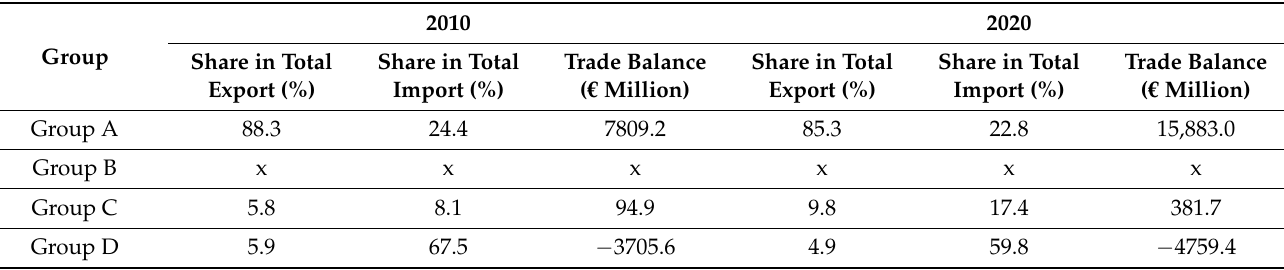
Figure 2. Mapping of selected groups of agri-food products exported from the EU to the USA depending on the level of comparative advantages and the degree of export specialization in the years 2010 and 2020 (the Widodo approach). Note: the figures present only the groups of products, which share in the structure of export or import to/from the USA in at least one analyzed year amount to min. 5%. Source: The author’s elaboration based on data from Table 5. Table 6. Shares of individual groups of products resulting from mapping by the Widodo method in agri-food trade of the EU with the USA and trade balance for these groups in the years 2010 and 2020